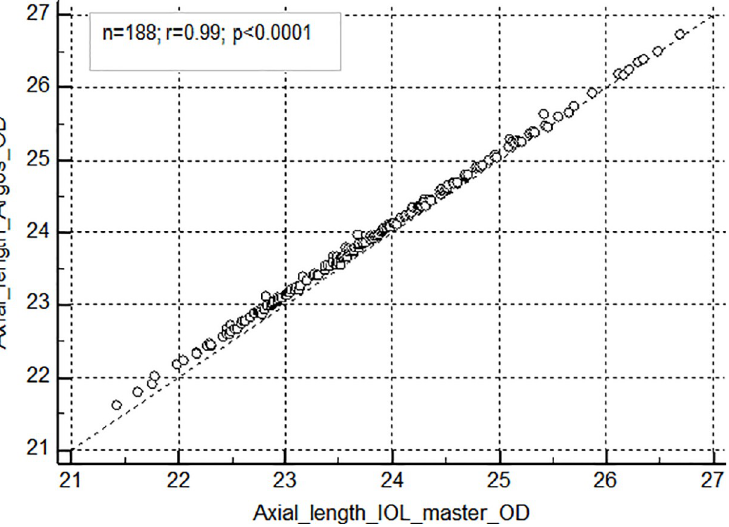
Fig 2. Correlation of axial length between Argos and IOL master biometers. AL-Axial length; OD–Right eye.